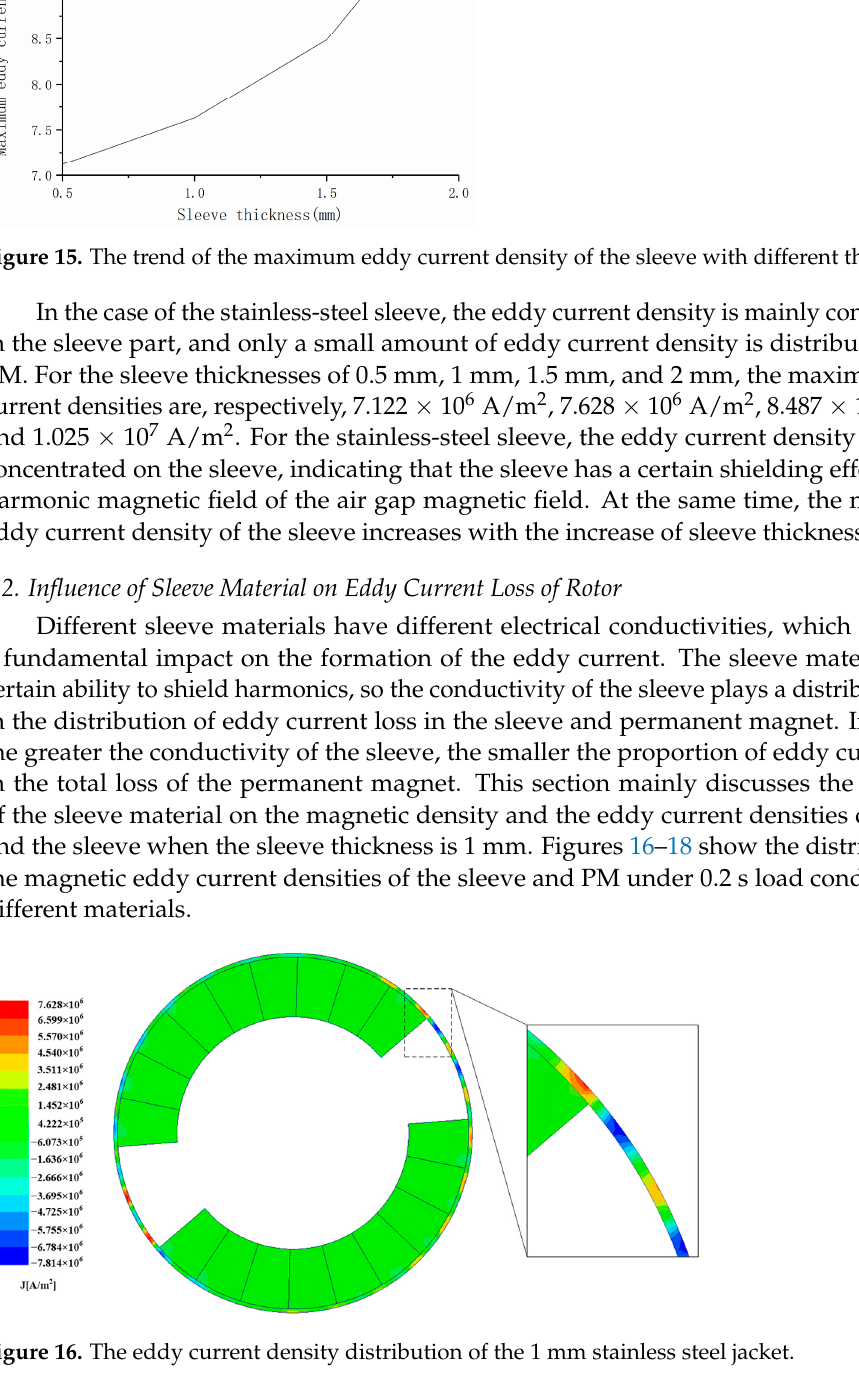
Figure 17. The eddy current density distribution of the 1 mm carbon fiber jacket.